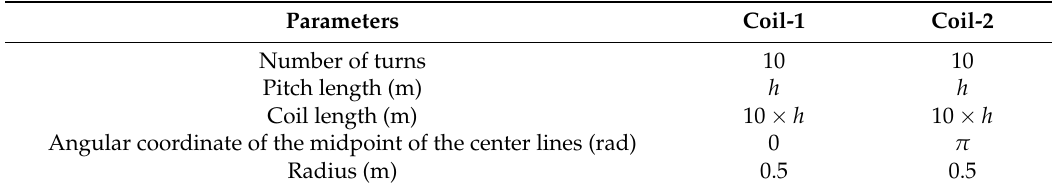
Table 8. Geometric parameters of the coils in Figure 3 (7th